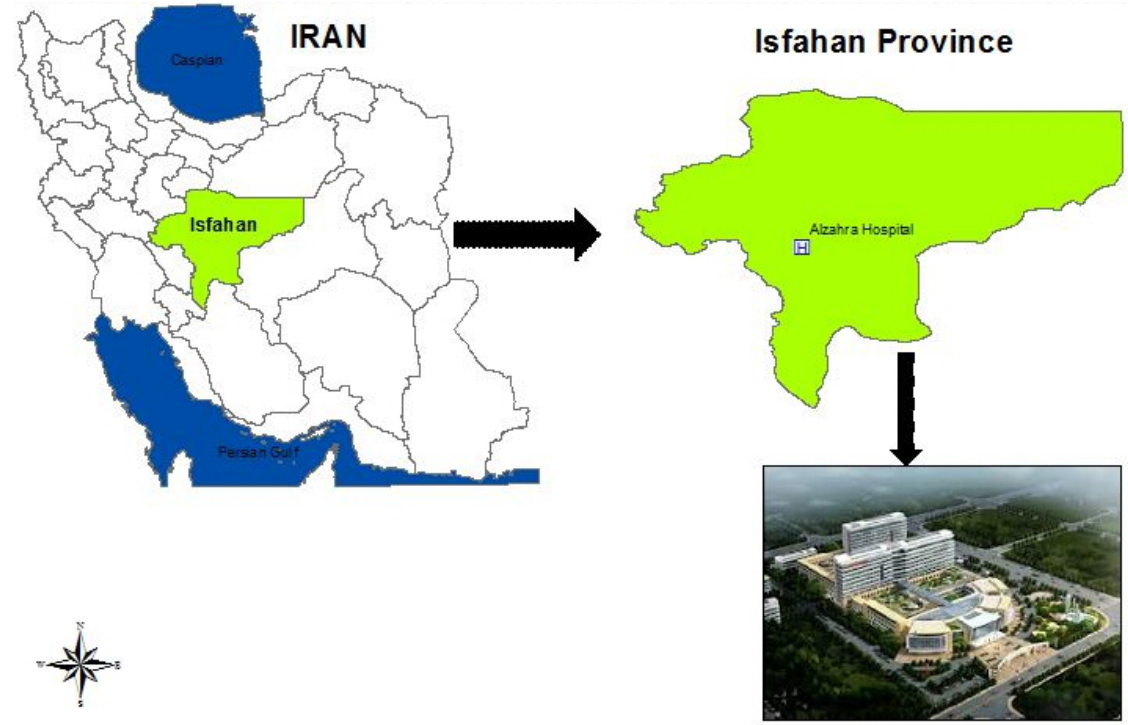
Fig. 2. Geographical location of hospital in Isfahan City in